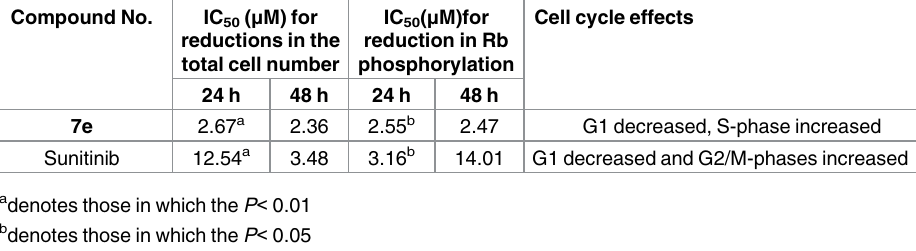
Table 3. IC 50 for reductions in the total cell number and cell cycle effects of compound 7e and sunitinib. Compound